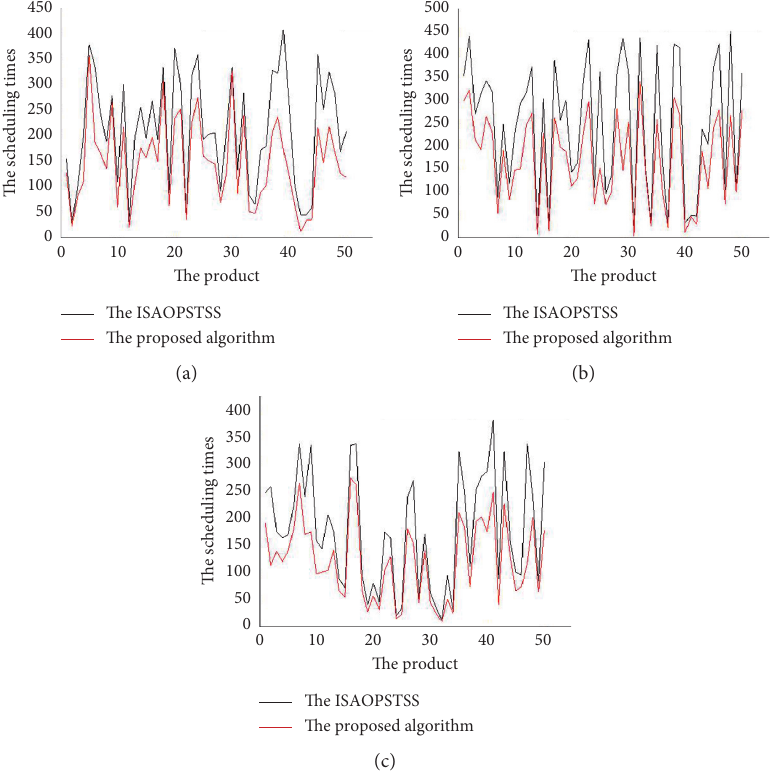
Figure 5: Comparison of scheduling times when the total number of processes is 30. (a) The scheduling times of 30 processes in 3 devices. (b) The scheduling times of 30 processes in 6 devices. (c) The scheduling times of 30 processes in 9